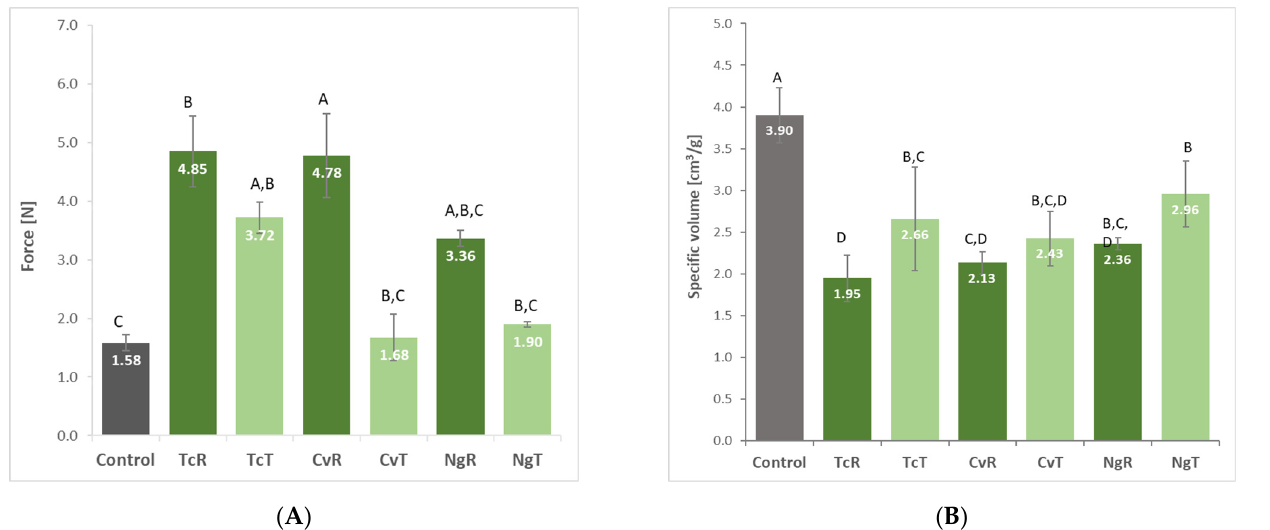
Figure 3. Crumb firmness ( A ) specific volume ( B ) of breads prepared with Tetraselmis chuii (TcR), Tetraselmis chuii ethanol-treated (TcT), Chlorella vulgaris (CvR), Chlorella vulgaris ethanol-treated (CvT), Nannochloropsis gaditana (NgR), and Nannochloropsis gaditana ethanol-treated (NgT). The values represent mean ± stdev of at least 3 replicates. Different letters for a given parameter indicate a significant difference ( p > 0.05) using the Fisher LSD test.